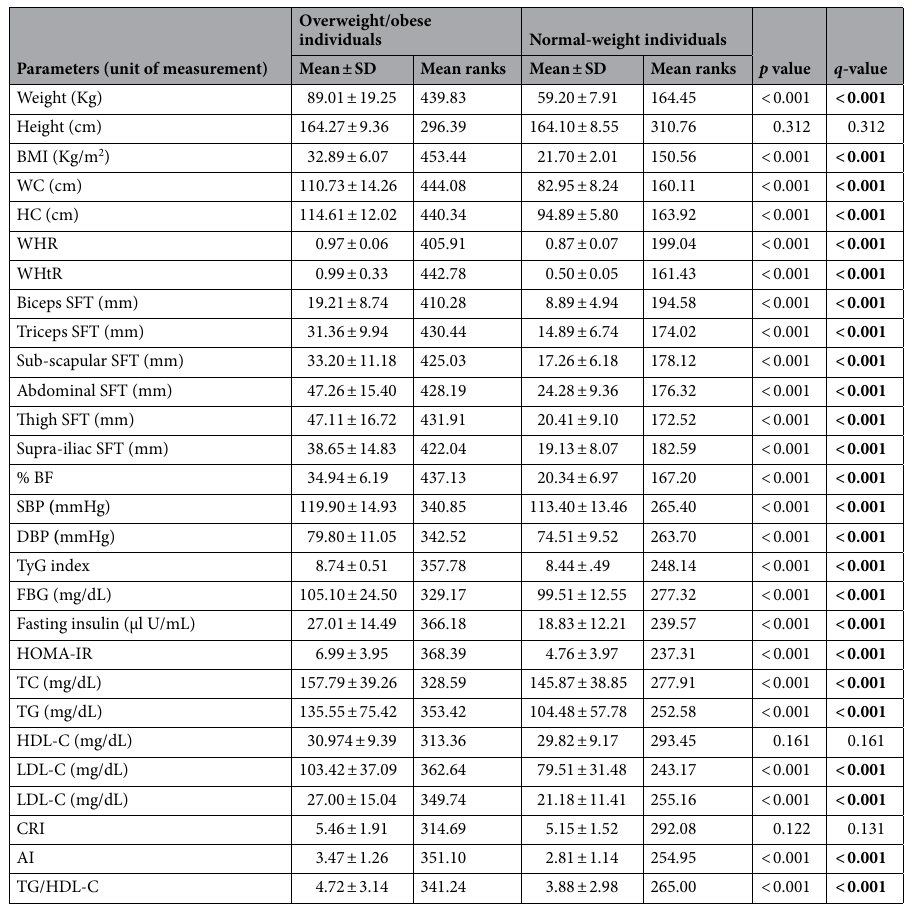
Table 1. Comparison of the obesity-related anthropometric and metabolic parameters between OW/ OB and NW individuals. OW/OB overweight/obese, NW normal-weight, BMI body mass index, WC waist circumference, HC hip circumference, WHR waist-to-hip ratio, WHtR waist-to-height ratio, SFT skinfold thickness, % BF body fat percentage, SBP systolic blood pressure, DBP diastolic blood pressure, TyG the product of triglycerides and glucose, FBG fasting blood glucose, HOMA-IR homeostatic model assessment- insulin resistance, TC total cholesterol, TG triglyceride, HDL-C high-density lipoprotein cholesterol, LDL-C low-density lipoprotein cholesterol, VLDL-C very-low-density-lipoprotein cholesterol, CRI Coronary Risk Index, AI Atherogenic Index, TG/HDL-C triglyceride-to-HDL-C ratio, SD standard deviation, CI confidence interval, q-value corrected p value. The comparison of the obesity-related anthropometric and metabolic parameters between overweight/obese and normal-weight individuals was determined by Mann–Whitney U test. The mean ± SD and mean ranks were calculated to show the difference of parameters between overweight/ obese and normal-weight individuals. The analysis was corrected for multiple comparisons via the Benjamini– Hochberg method of false discovery rate (FDR) control. A p value < 0.05 was considered statistically significant. The significant p values are indicated in bold .